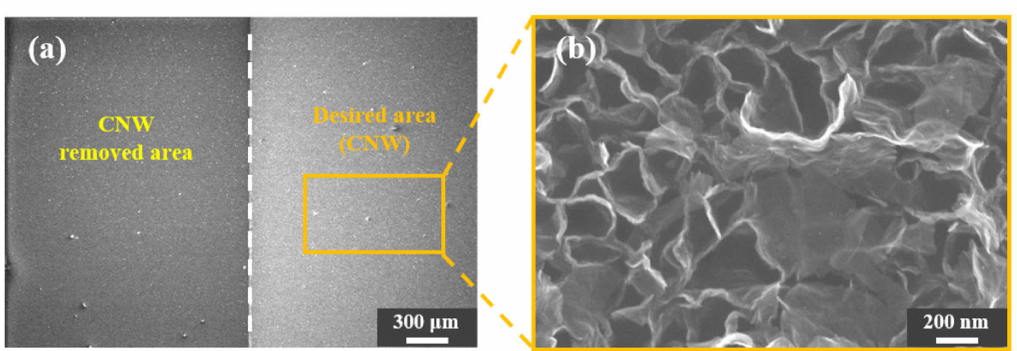
Figure 5. FESEM surface image ( a ) after sonication of the CNW grown on a Si wafer (removed area) and a Ag / SiO 2 layer (desired area) without PR coating. ( b ) FESEM image of 300 K magnification in the CNW grown on the desired area after